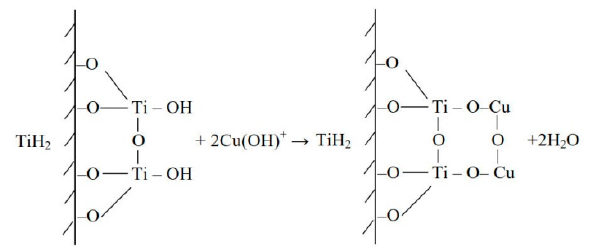
Figure 13. Scheme of interaction of partially hydrolyzed copper ions with hydroxotitanyl during thermal